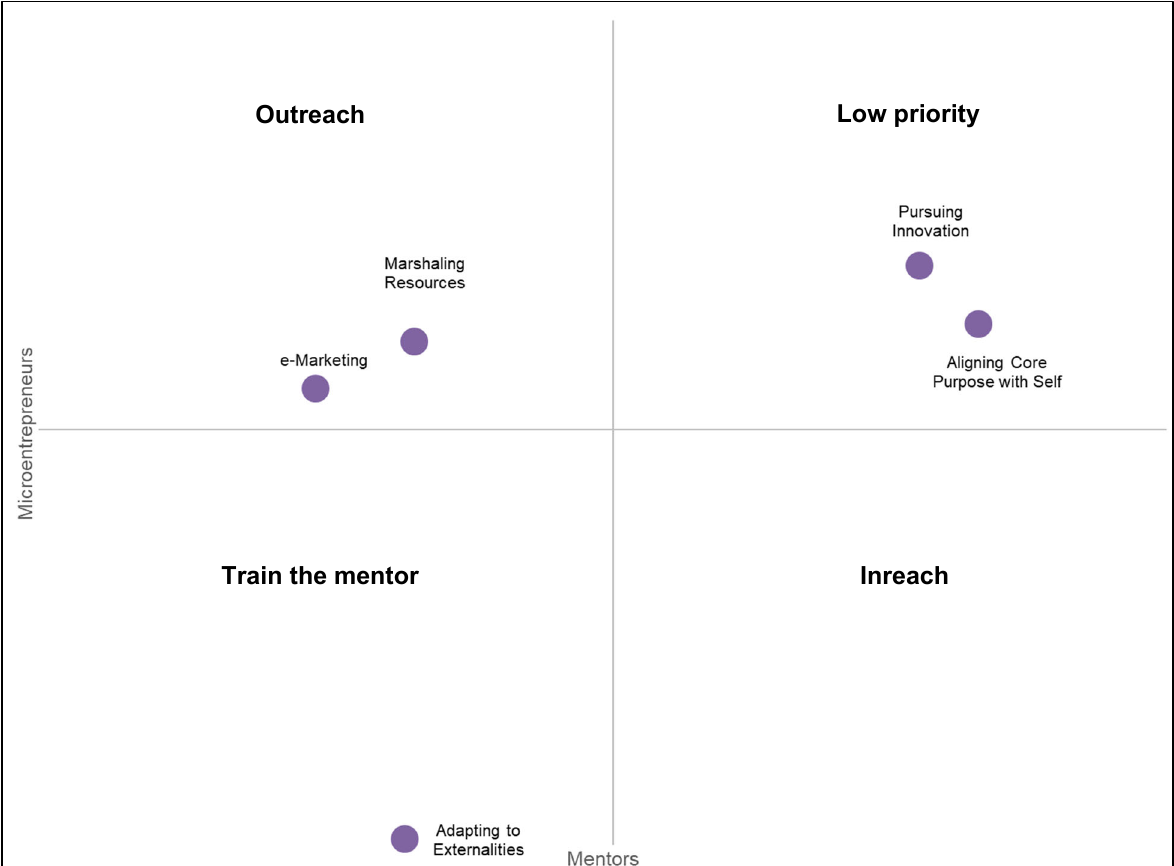
Figure 2. Microentrepreneurship Mentoring